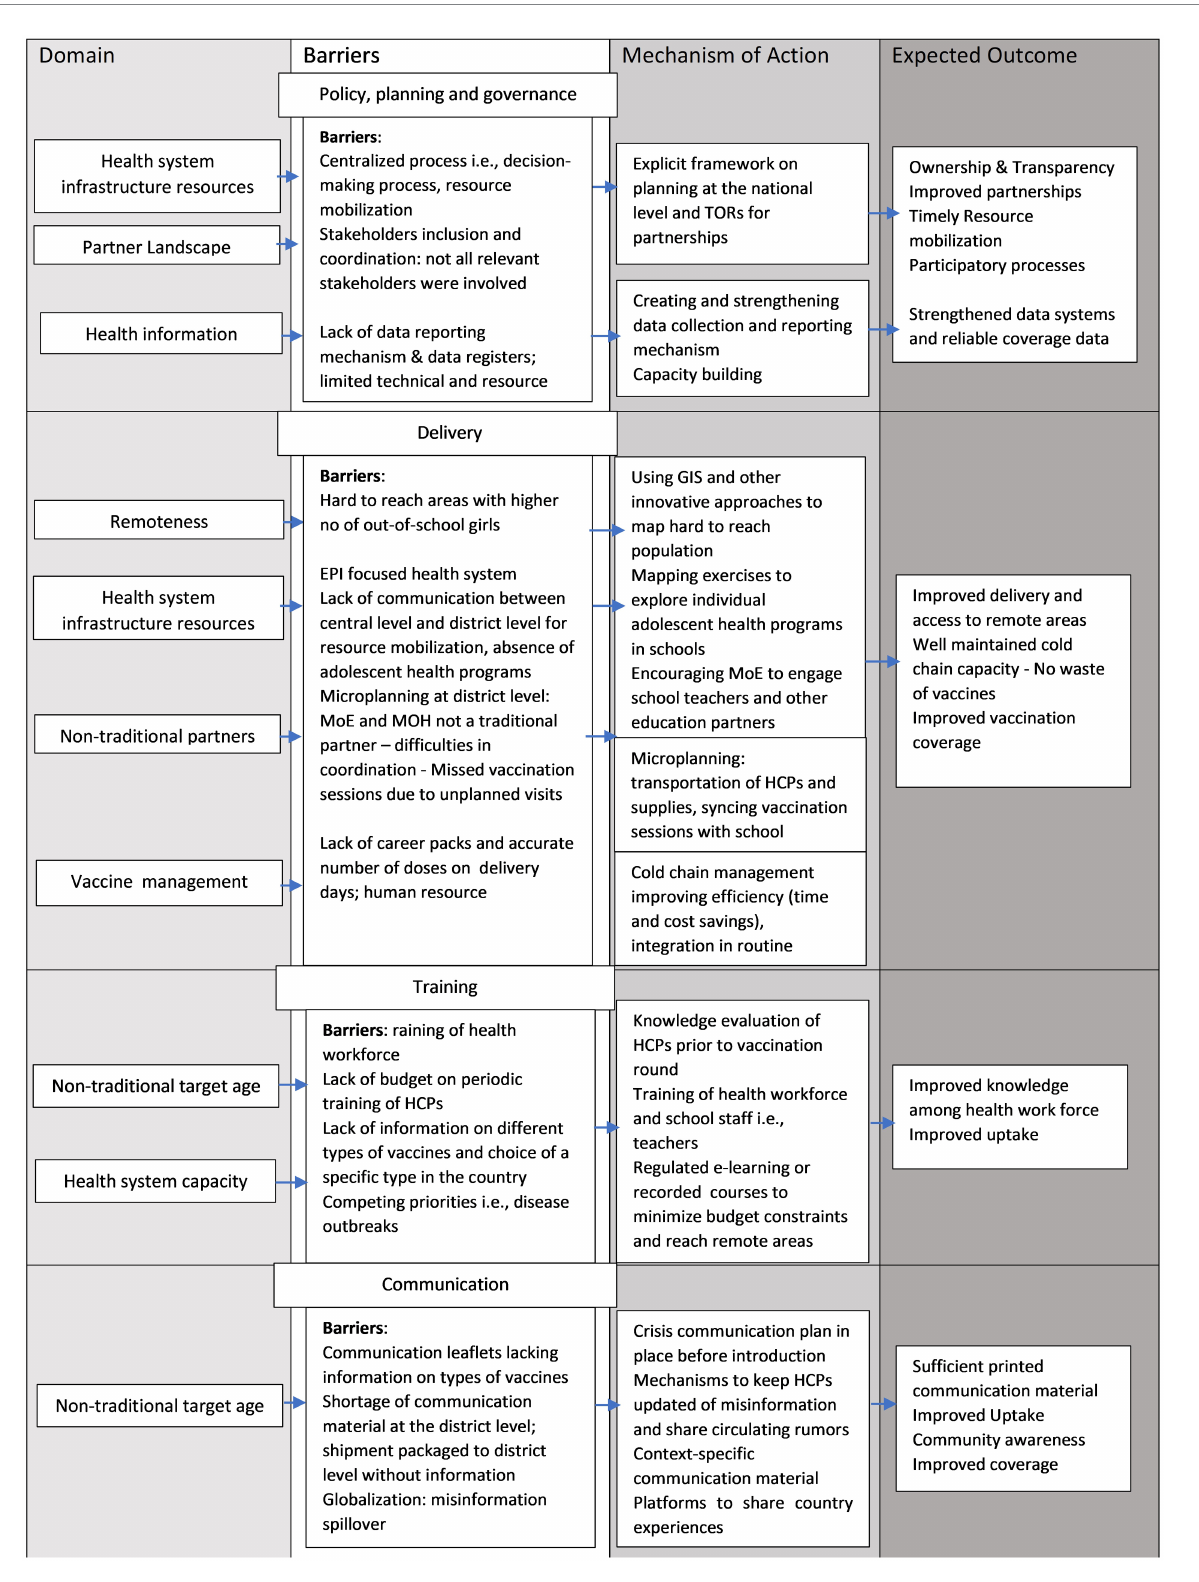
FIGURE 2 Domain-Specific Barriers and Mechanisms of Action for Enhancing HPV Vaccination Program Performance. This figure includes domain-specific barriers to various parameters of HPV vaccination programs. These barriers can be addressed through mechanisms of action that can improve outcomes for the HPV vaccination